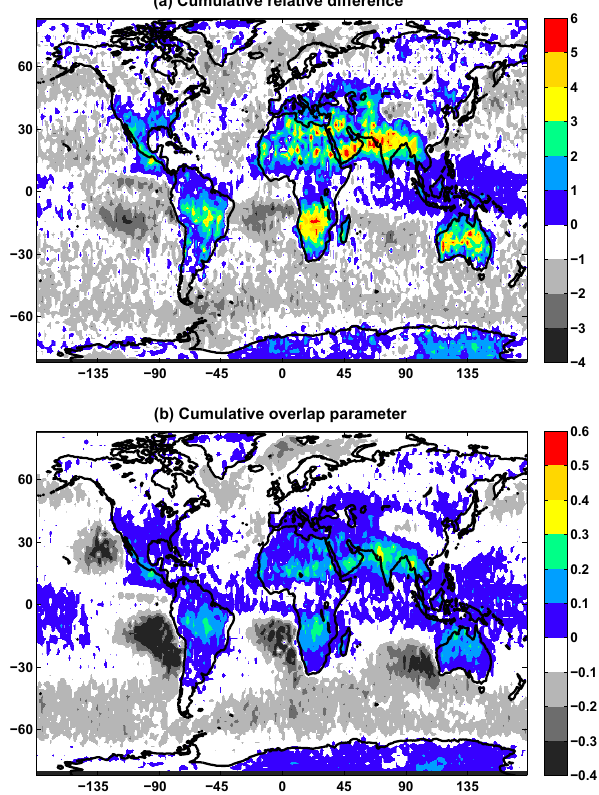
Figure 9. The global distributions of (a) the cumulative relative dif- ference and (b) the cumulative overlap parameter of all multilayered cloud